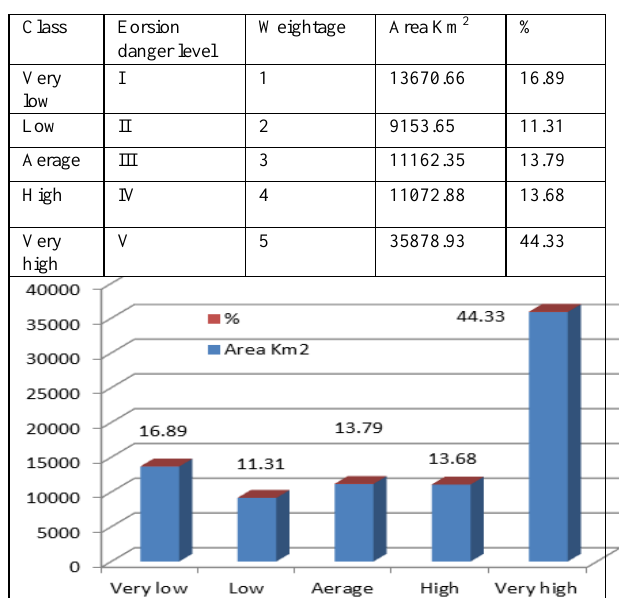
TABLE 8. Classification of erosion danger